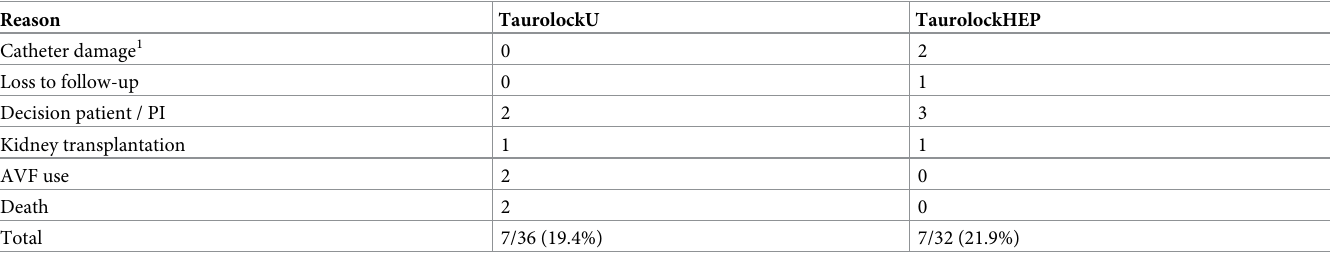
Table 4. Reasons for early study termination other than refractory